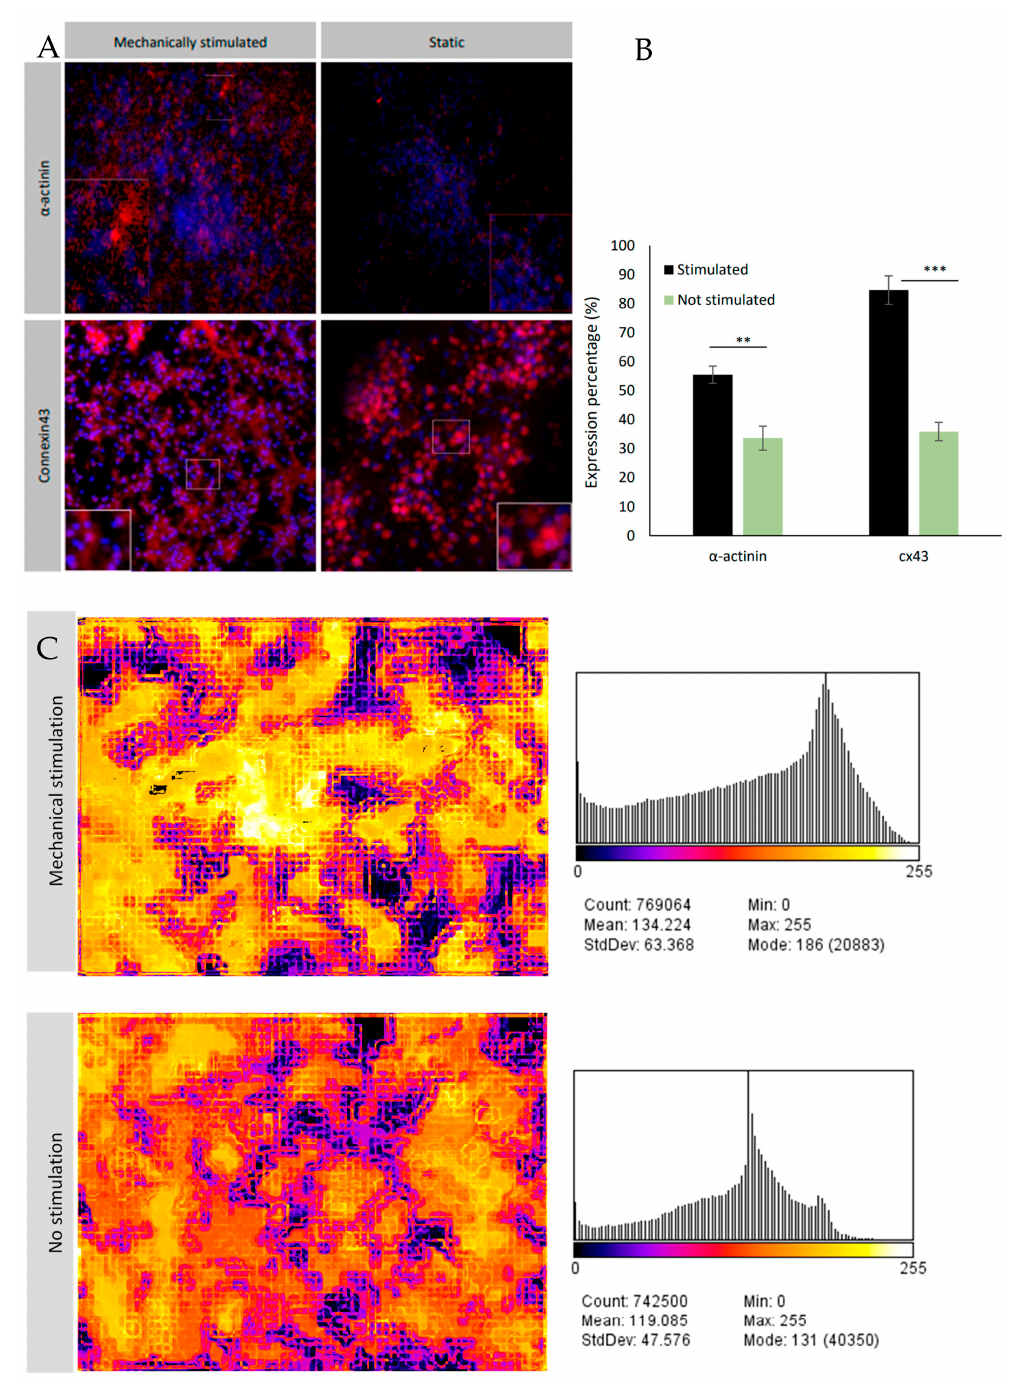
pattern parallel to the stretching; ( D ) 3D condition without pattern; ( E ) 3D condition with pattern perpendicular to the direction of stimulation; and ( F ) 3D condition with the pattern parallel to the stretching (15%, 1 Hz). ( G ) The competition between mechanical and topological patterning. ( H ) The degree of orientation in different culture conditions (orientation degree is related to the angle between cell orientation and stretching direction). Error bars represent the mean ± standard deviation (SD) of the measurements (** p < 0.01).